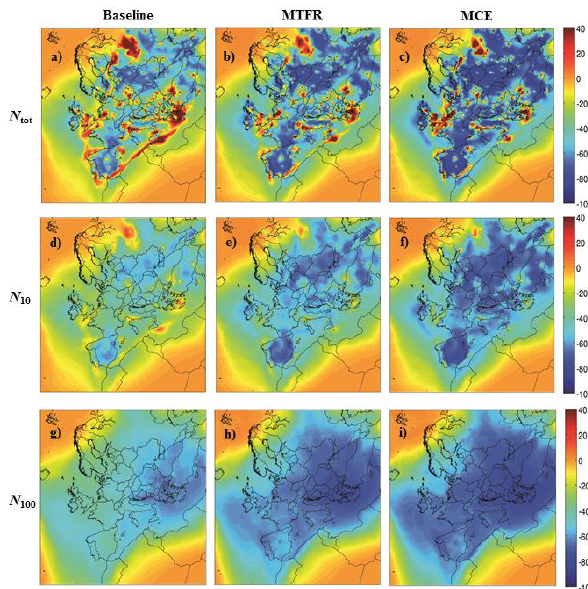
Fig. 2. Predicted percentage change in mean concentration from Fig. 2: Predicted percentage change in mean concentration from 2008 to 2030 for the three 967 2008 to 2030 for the three future scenarios for N tot (a–c) , N 10 (d–f) , future scenarios for N tot (a-c), N 10 (d-f), and N 100 (g-i). 968 and N 100 (g–i) .